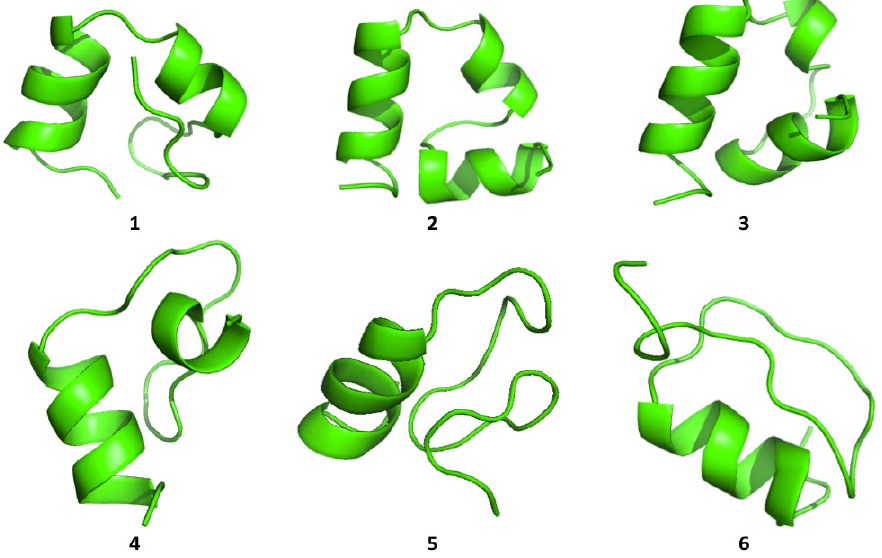
Figure 4. The representatives of the six most populated structural clusters for